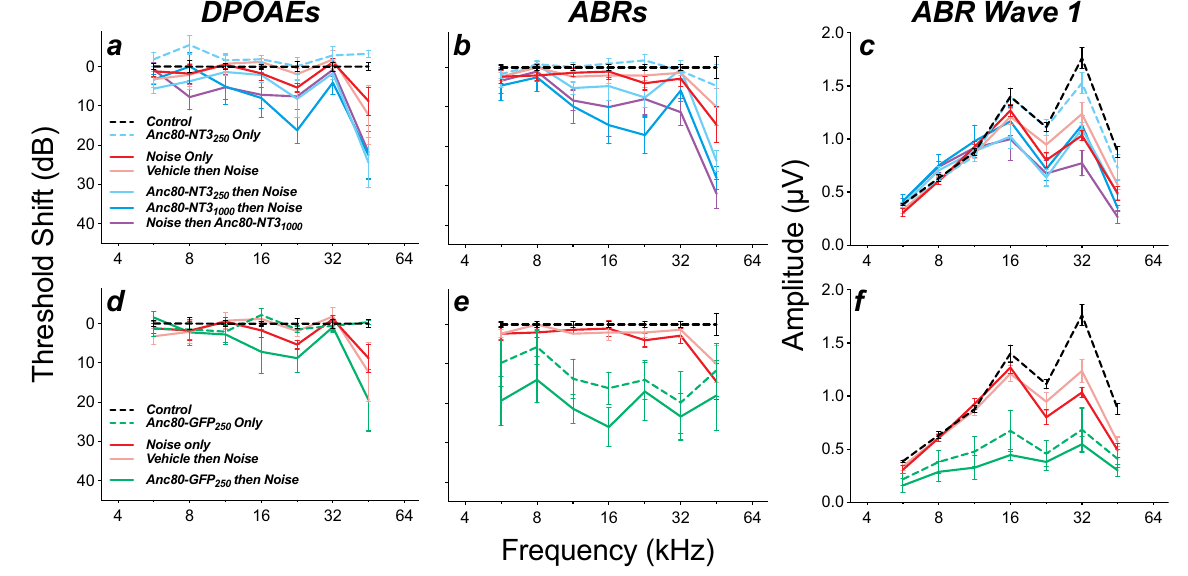
Figure 7. NT3 overexpression slightly increased noise-induced threshold shift in both DPOAEs ( a ) and ABRs ( b ), with a concomitant reduction in wave 1 amplitudes ( c ). GFP overexpression similarly increased noise- induced DPOAE thresholds shifts ( d ), while greatly increasing ABR thresholds ( e ) and reducing ABR wave 1 amplitudes ( f ) with or without noise exposure. Groups and group sizes were as follows: Controls (n = 15), Noise Only (n = 10), Vehicle then Noise (n = 5), Anc80-NT3 250 Only (n = 6), Anc80-NT3 250 then Noise (n = 7), Anc80-NT3 1000 then Noise (n = 8) and Noise then Anc80-NT3 1000 (n = 5). Group sizes for the GFP groups were as follows: Anc80-GFP 250 Only (n = 7), and Anc80-GFP 250 then Noise (n = 5). Wave 1 amplitude is extracted from each case at each frequency by averaging results from stimulus levels of 60, 70, and 80 dB SPL. Means ( ± SEMs) are shown in all plots. All data are normalized to mean values in unexposed